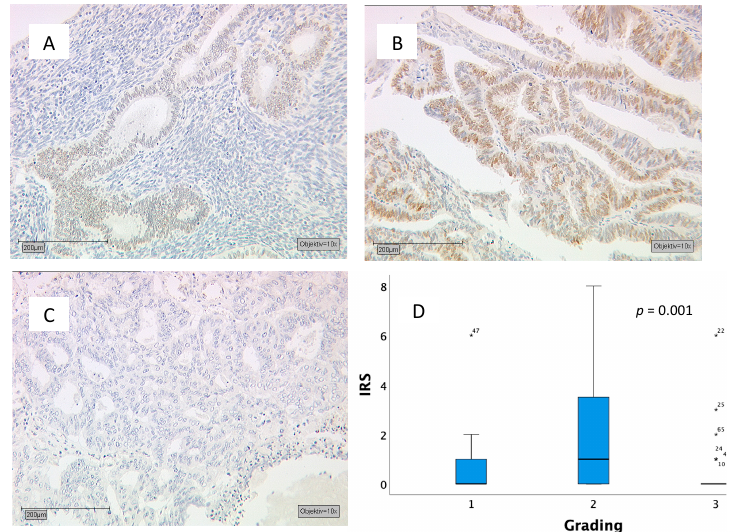
Figure 2. ( A – C ) Tumor samples stained for MSX1: ( A ) Grading 1 tumor with an IRS of 2 (endometrioid ovarian carcinoma); ( B ) Grading 2 tumor with an IRS of 6 (endometrioid endometrial carcinoma); ( C ) Grading 3 tumor with an IRS of 0 (endometrioid endometrial carcinoma); ( D ) Boxplots with a median IRS of 1 for grading 2 tumors (moderately di ff erentiated) and with a median IRS of 0 for grading 1 (well-di ff erentiated) and grading 3 (badly di ff erentiated) tumors. Asterisks indicate values which are more than 2times the box length. Numbers at asterisks indicate sample